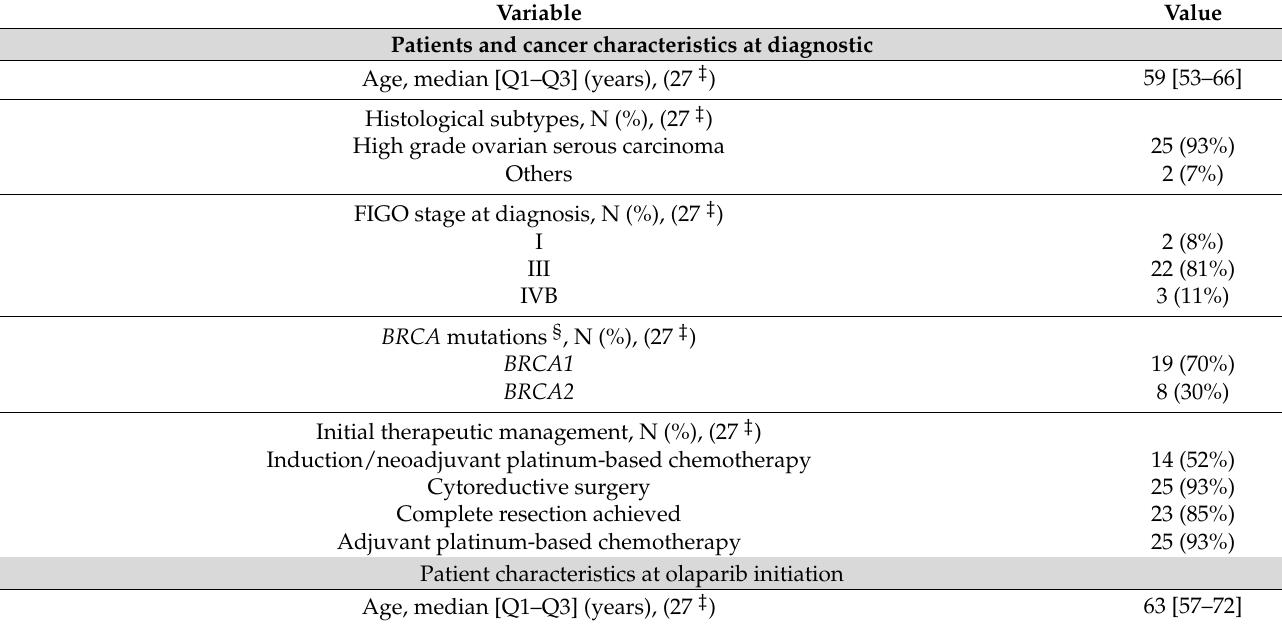
Figure 1. Flow chart. * Olaparib-related iatrogenic adverse events were considered as any clinically significant adverse event (SAE) defined by: (i) grade III–IV adverse events, or (ii) adverse events resulting in dose reduction or treatment discontinuation. Table 1. Patient and cancer characteristics.